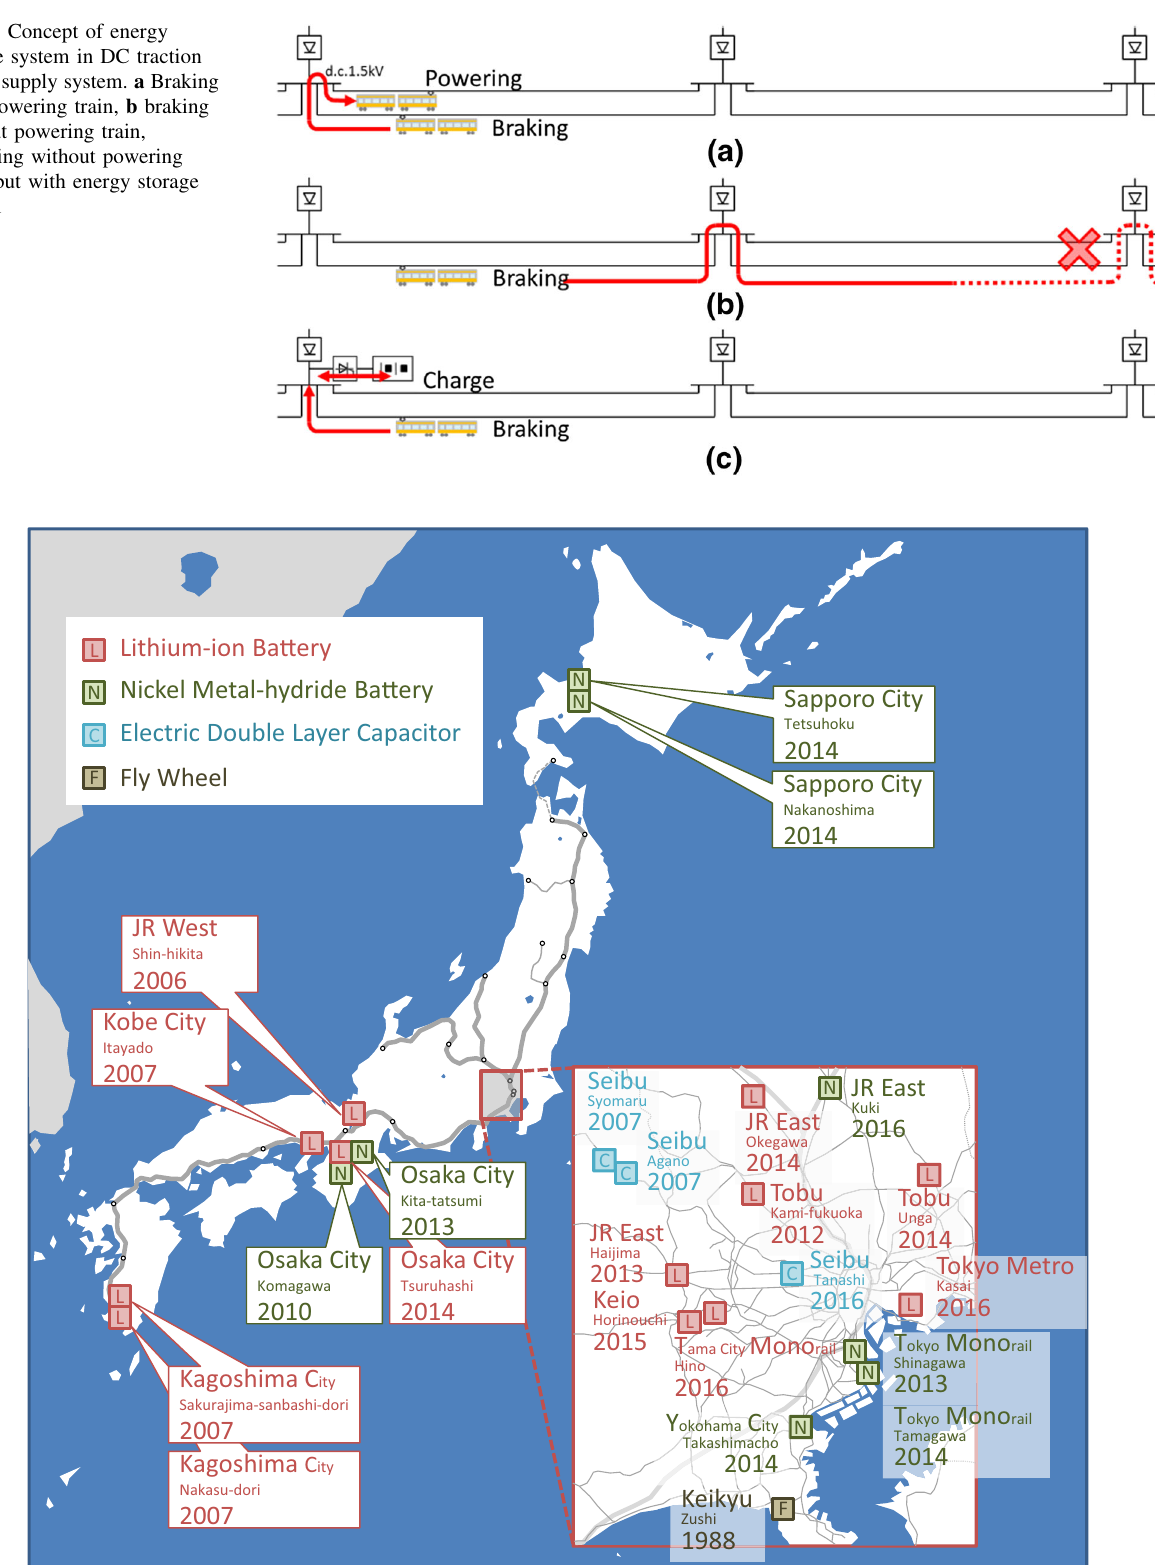
Fig. 8 Existing energy storage systems in DC traction power supply system in